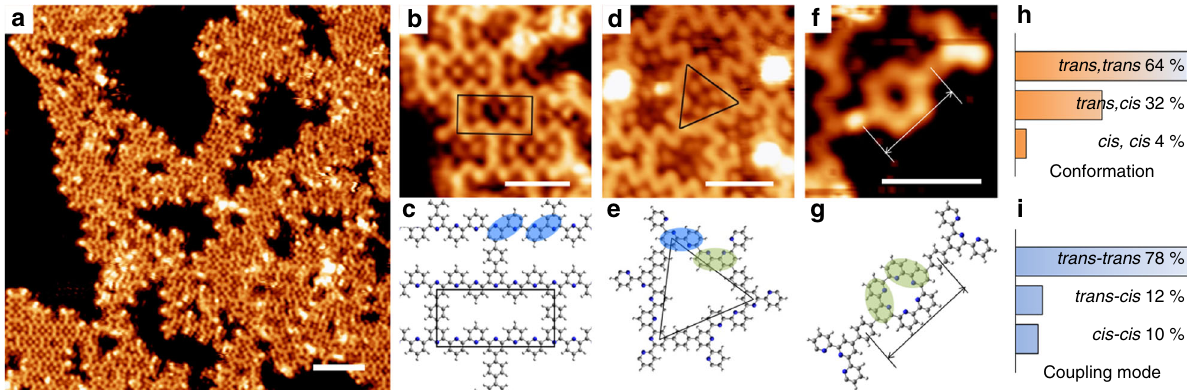
Fig. 3 Uncontrolled debrominated aryl-aryl coupling reaction. a STM overview of the sample after annealing at 661 K. b – g Three typical conjugated sub- structures and the corresponding structural models. The conformations of bpy fragments are highlighted by ovals in different colors ( trans , blue; cis , green). Different as-formed bpy-bpy connections are observed, namely trans-trans , trans - cis and cis-cis . h Statistic analysis of the molecular conformers (based on the conformations of tpy terminals). i Statistic analysis of the three typical C-C coupling modes of the bpy-bpy connections. Scale bars: ( a ) 5 nm; ( b , d , and f ) 2 nm. Data acquisition conditions ( T = 293 K): ( a ) − 1.0 V, 0.4 nA; ( b ) − 0.5 V, 0.2 nA; ( d ) − 0.6 V, 0.15 nA; ( f ) − 0.5 V, 0.08